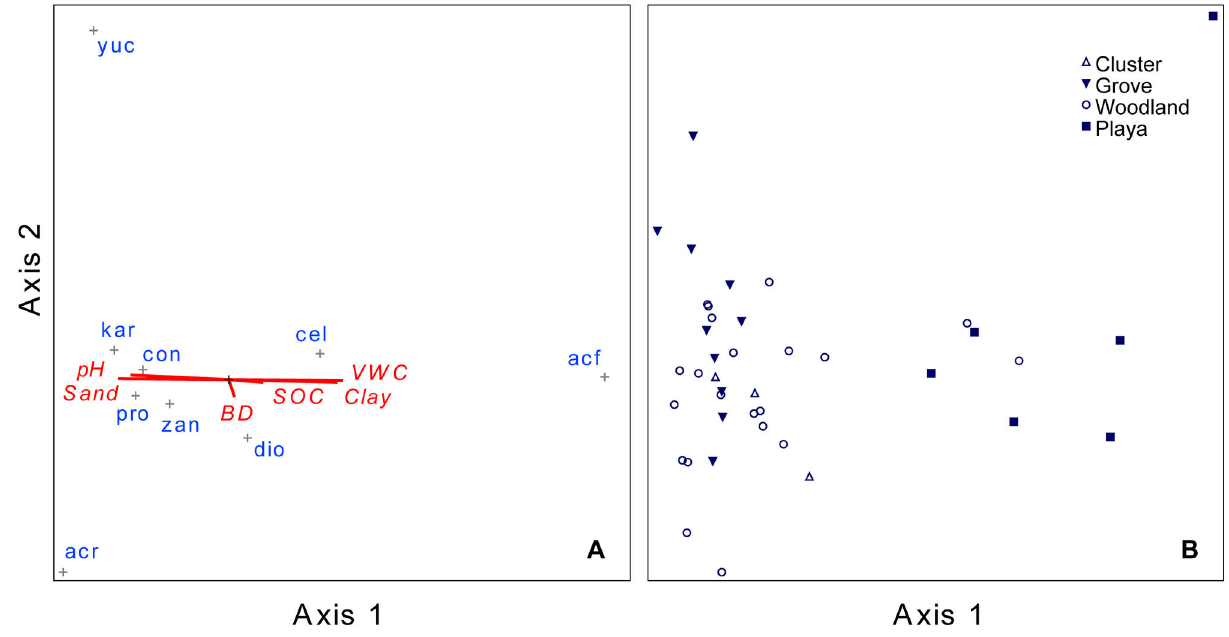
Figure 3. CCA Ordination (canonical correspondence analysis) results ordered in multivariate space along the first two canonical axes, separately depicting relationships among (A) tree-stature species (Table 1) and soil variables; and (B) communities in each 6 m × 6 m sample plot (symbols indicate community type) along a hill-slope transect. Species centroids (+) indicate center of distribution among sample plots for each tree species coded as follows: acf = Acacia farnesiana ; acr = Acacia rigidula ; cel = Celtis pallida ; con = Condalia hookeri ; dio = Diospyros texana ; kar = Karwinskia humboltiana ; pro = Prosopis glandulosa ; zan = Zanthoxylum fagara . Lines are vectors indicating direction of increasing value (from center outward) for soil variables as follows: BD = bulk density; Sand and clay = soil particle percentages; SOC = soil organic carbon; TN = total nitrogen.